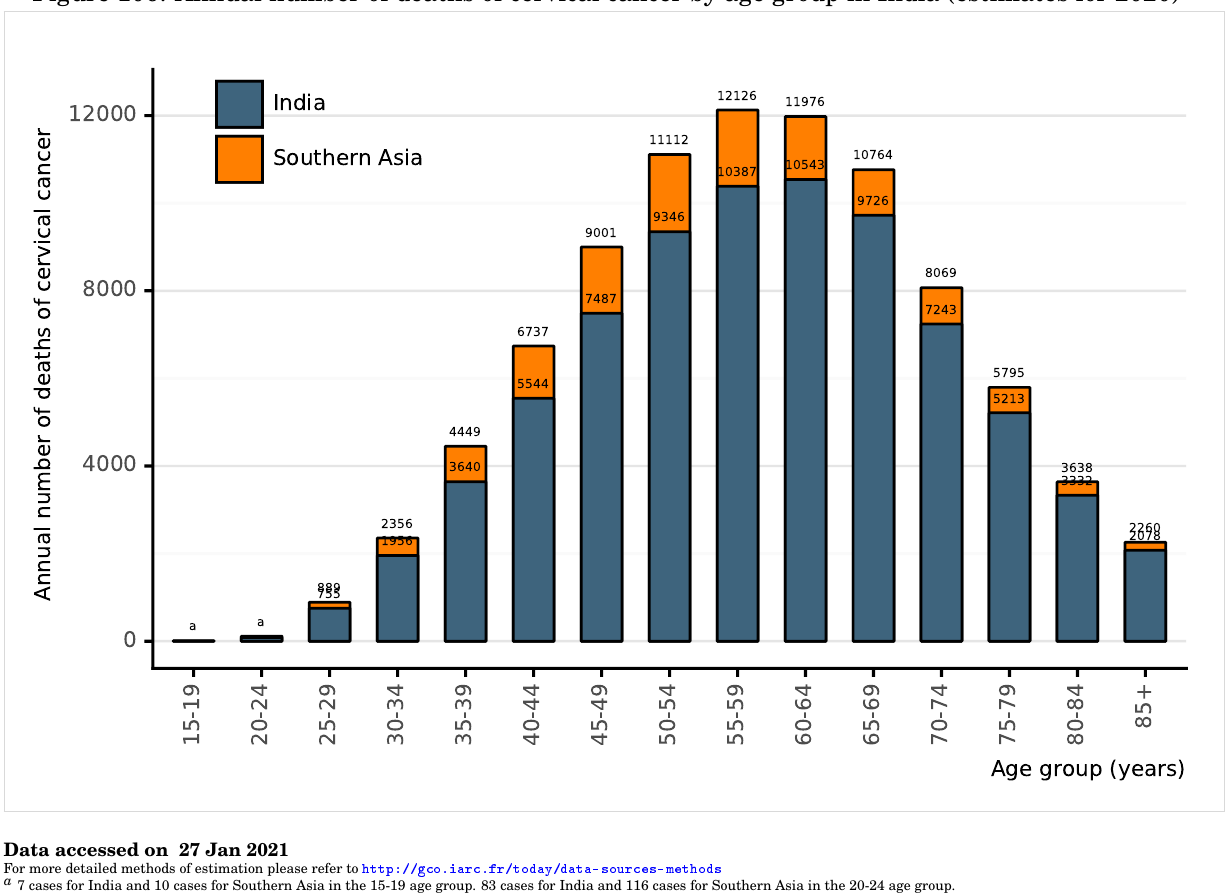
Figure 106: Annual number of deaths of cervical cancer by age group in India (estimates for